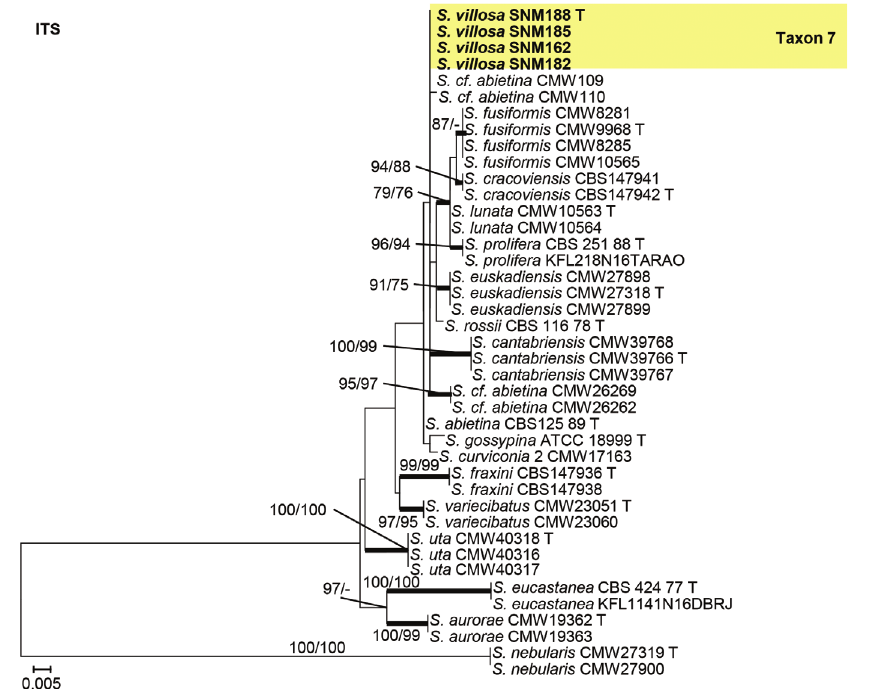
Figure 6. Maximum likelihood phylogeny of Sporothrix gossypina species complex using complete ITS region. The isolates recovered in this study are highlighted in color and in bold font. ML and MP boot- strap support values ≥ 75 are indicated at the nodes as ML/MP. Bold branches indicate posterior prob- abilities values ≥ 0.9. T indicates ex-type